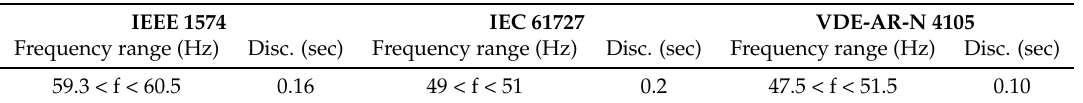
Table A4. Frequency deviations and disconnection time.